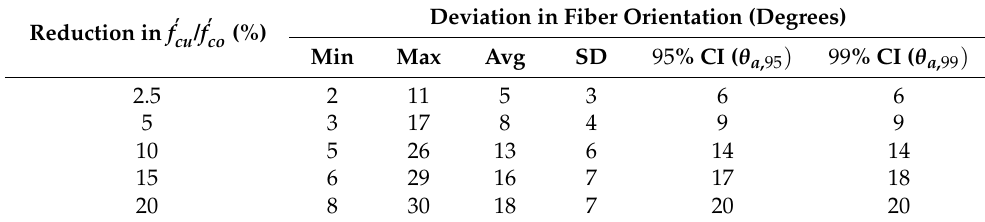
Table 7. Fiber orientations for different reductions in f (cid:48) cu / f (cid:48) co